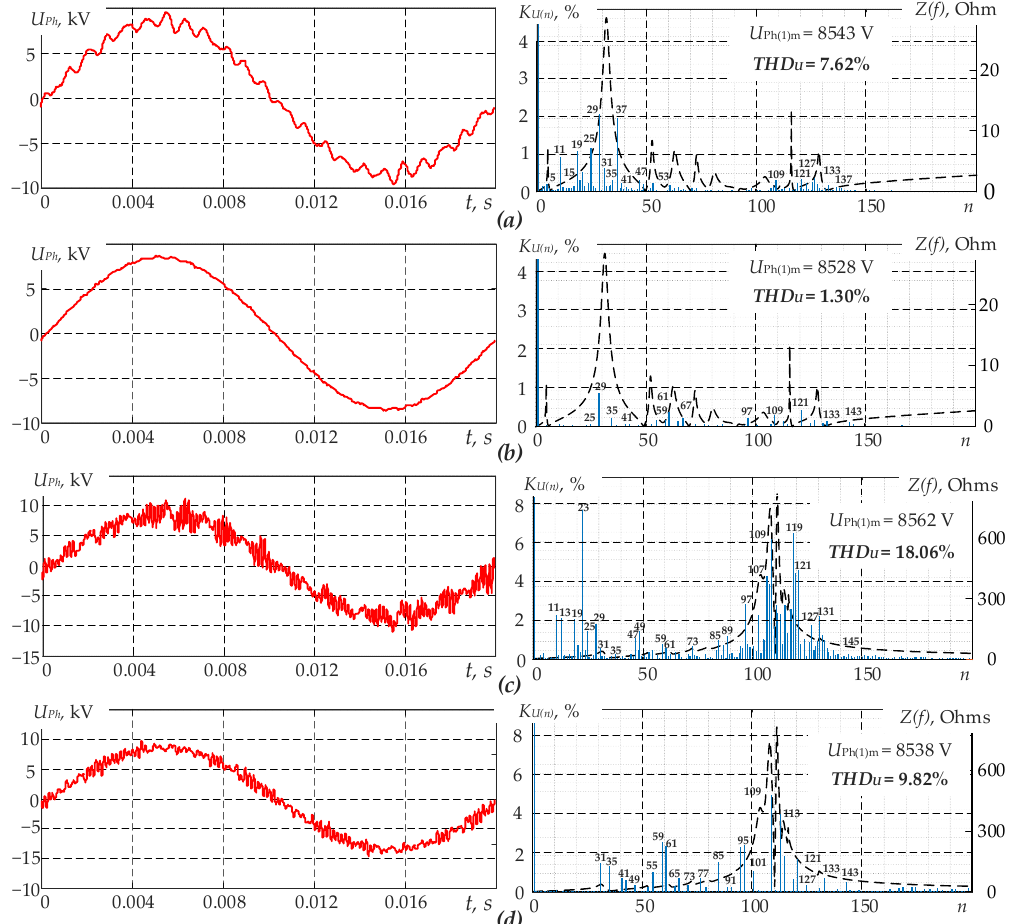
Figure 27. The comparison of the phase voltage oscillograms of the MSDS 10 kV grid ( a,b ) and the RP-19 substation ( c,d ) and their spectral analysis: ( a,c ) before using adaptive AFEPWM; ( b,d ) after using adaptive AFEPWM.